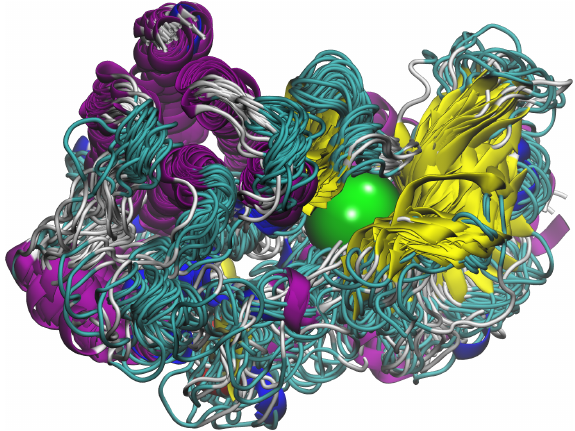
Figure 2. Position of the average center-point (as a green sphere) found from the 45 used conformers and used for the